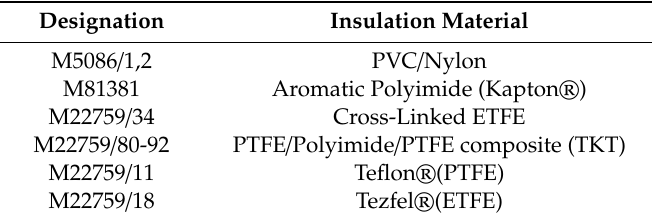
Table 1. Common aircraft